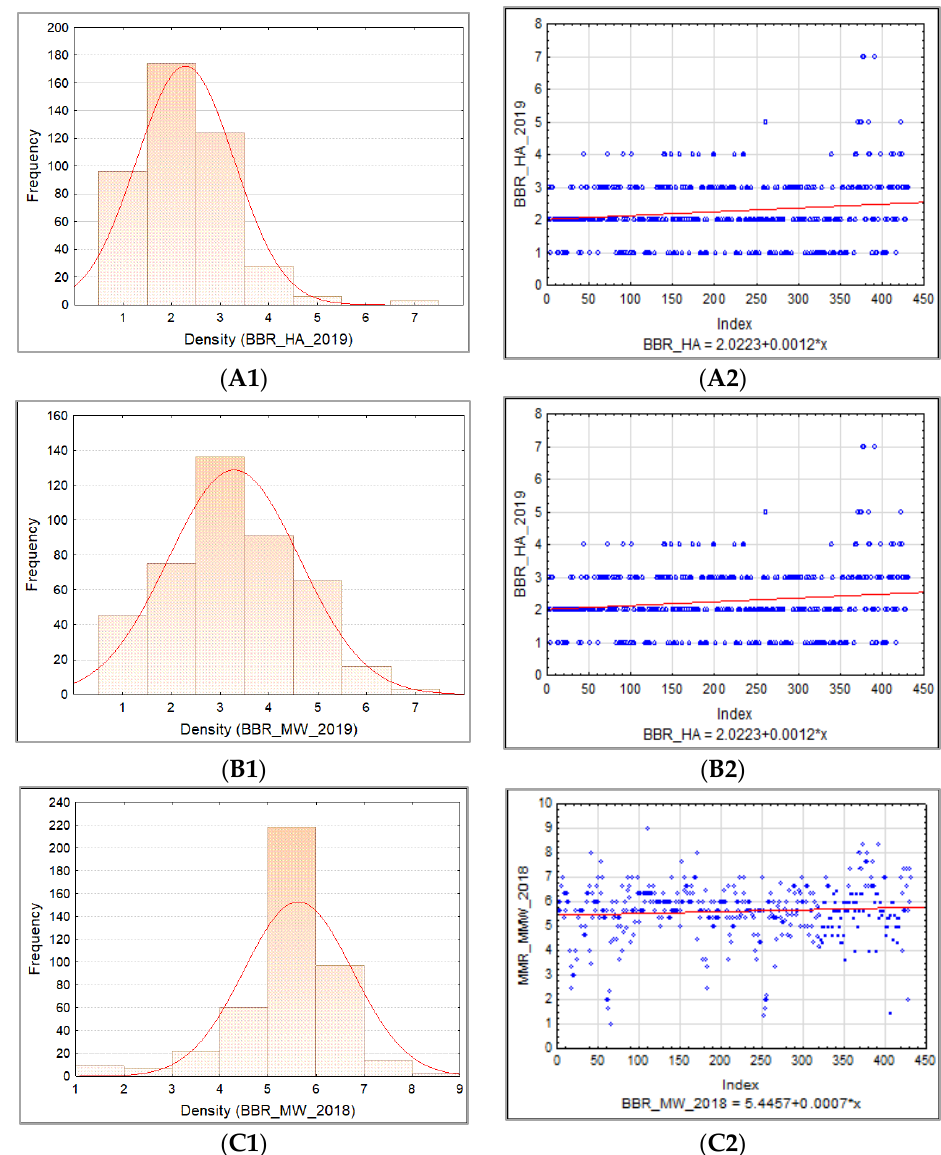
Figure 9. Frequency distribution of the barley accessions for the barley brown rust (BBR) resistance scores at the heading (HA) and milky-wax (MW) stages in 2019 and MW stage in 2018. Figures ( A1 ), ( B1 ), and ( C1 ) present the normal Gauss frequency distribution. Figures ( A2 ), ( B2 ), and ( C2 ) present regression analysis model to estimate relationship between the BBR resistance scores and the frequency index. Disease severity scored on the 1 – 9 scale (1 = immune reaction).